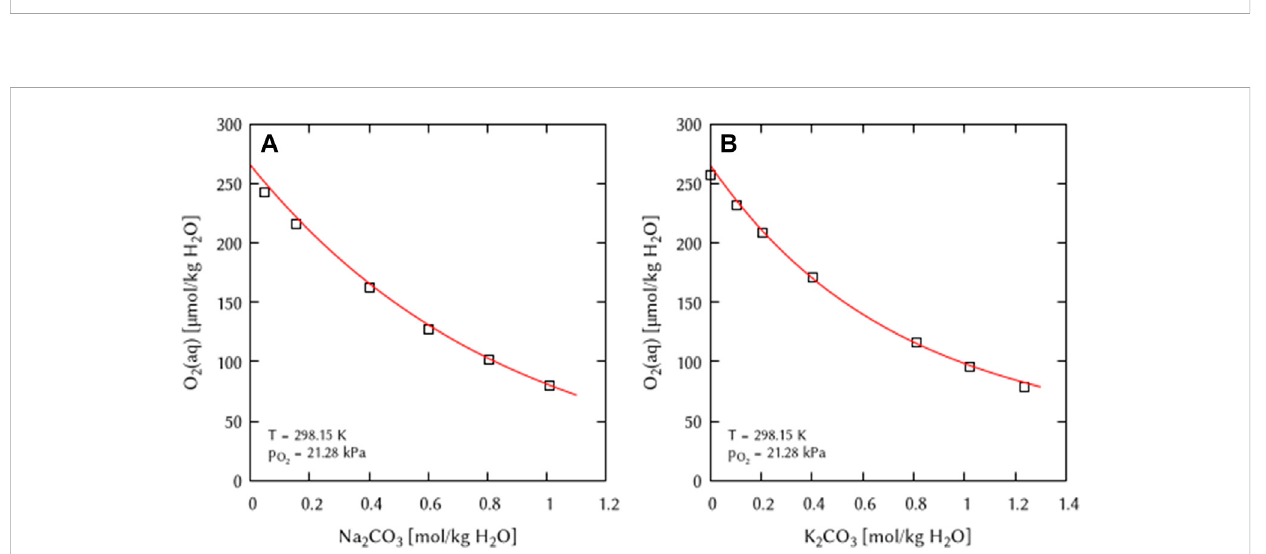
FIGURE 6 Modelling of the O 2 solubility in binary solutions of (A) Na 2 CO 3 , and (B) K 2 CO 3 as a function of the electrolyte concentration at T = 298.15 K (Points: Experimental data from □ Khomutov and Konnik (1974), Lines: this